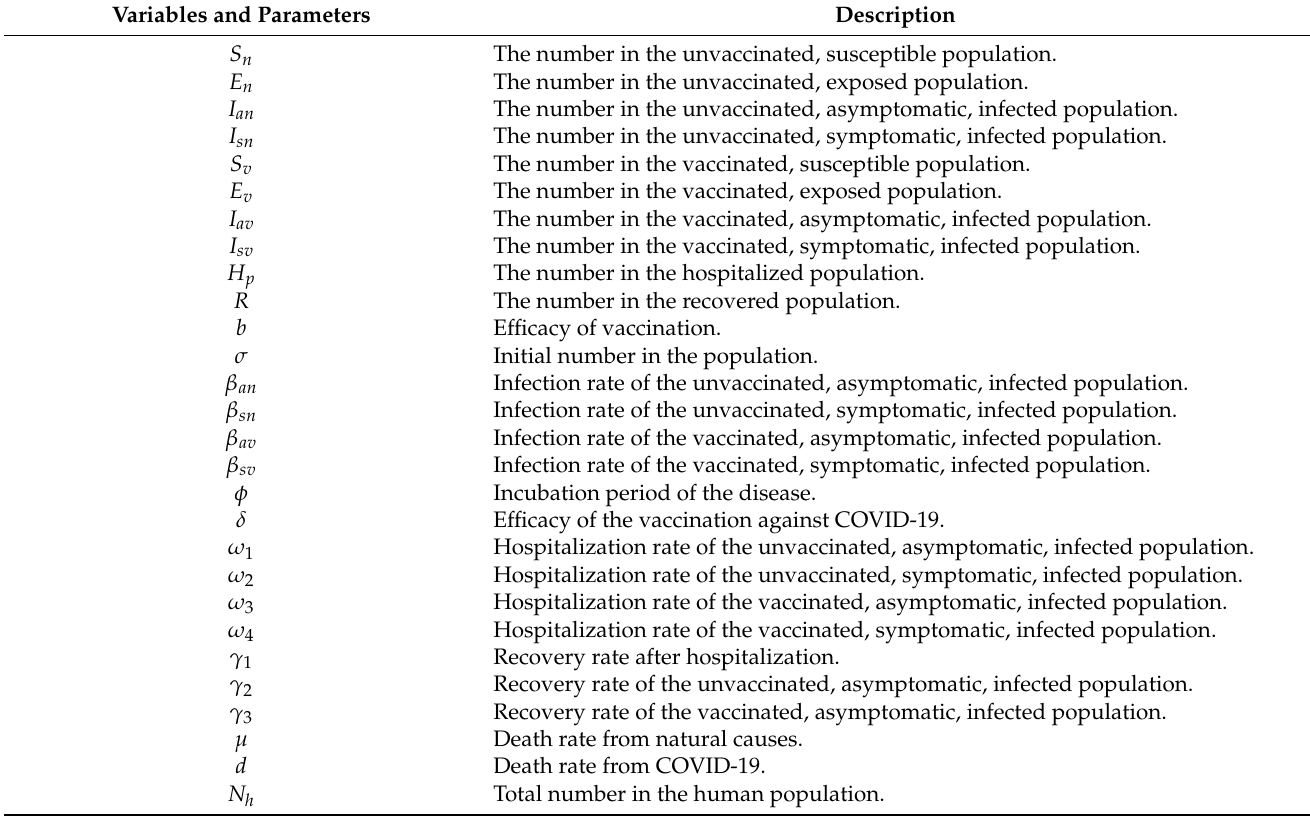
Table 1. Definitions of variables and parameters. Variables and Parameters